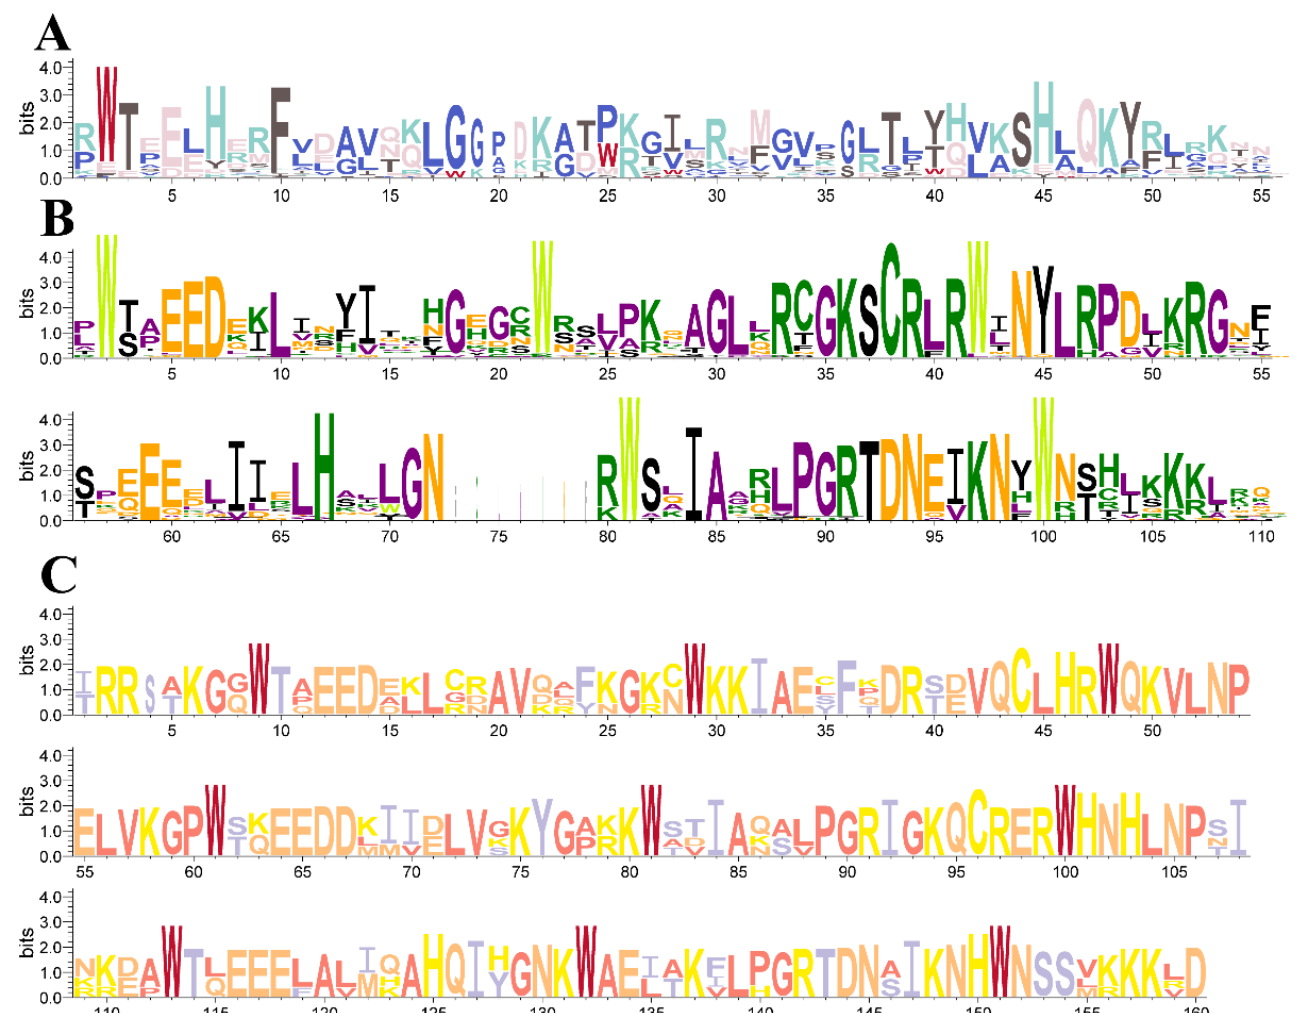
Figure 2. DNA-binding domains in CcMYBs . ( A ). The sequence logos of the 1R-MYB in C. camphora ; ( B ). The sequence logos of the R2R3-MYB in C. camphora , R2 repeat in the first row, R3 repeat in the second row; ( C ). The sequence logos of the 3R-MYB in C. camphora , R1 repeat in the first row, R2 repeat in the second row, and R3 repeat in the third row. The bit score represents the information content at each position in sequences. G: Glycine; A: Alanine; V: Valine; L: Leucine; I: Isoleucine; P: Proline; F: Phenylalanine; Y: Tyrosine; W: Tryptophan; S: Serine; T: Threonine; C: Cystine; M: Methionine; N: Asparagine; Q: Glutarnine; D: Asparticacid; E: Glutamicacid; K: Lysine; R: Arginine; H: Histidine.